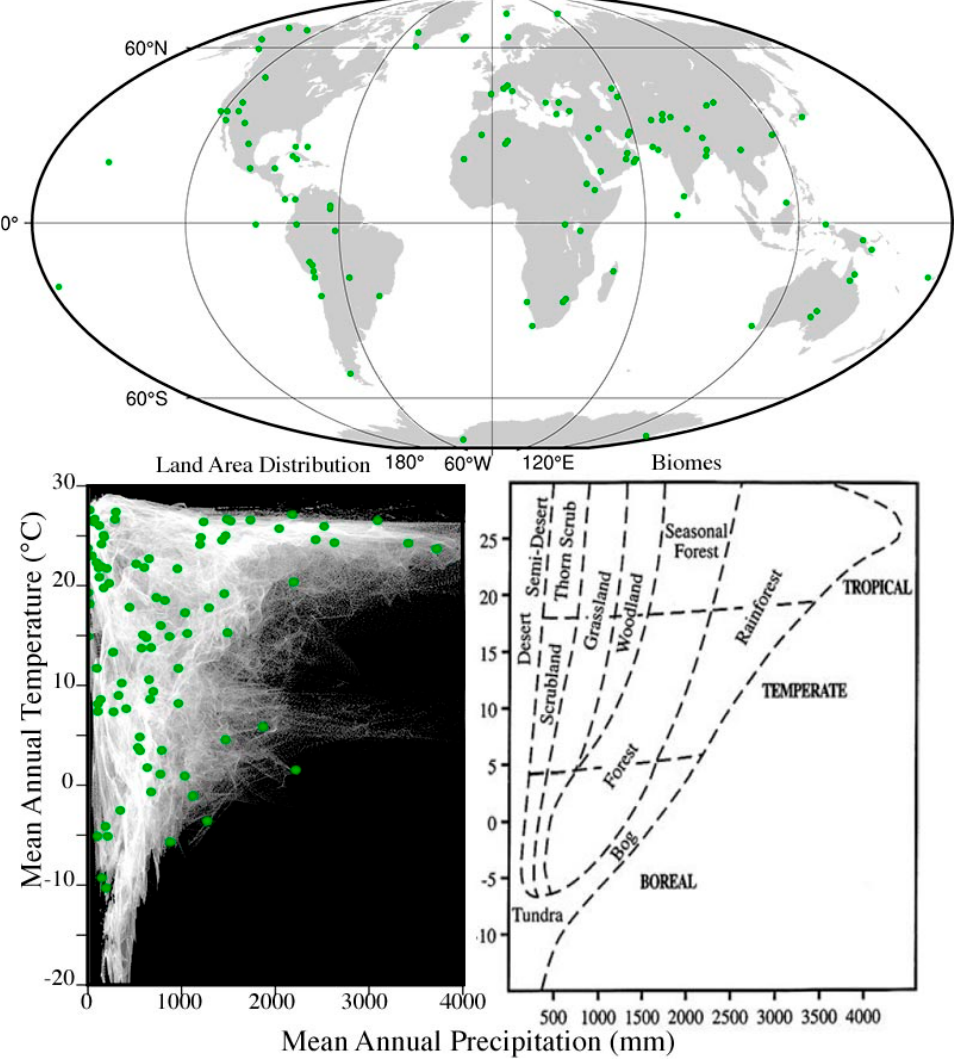
Figure 1. Geographic and climatic distributions of 110 Sentinel 2 tiles from spectral diversity hotspots. Geographic distribution of sample sites is guided by climatic and geologic diversity as well as overall species biodiversity. Individual tile selection criteria favor spectral diversity arising from land cover diversity within and across biomes. Tile geographic coverage corresponds well to global land area distribution within the climatic parameter space (lower left) based on 1° monthly from [14]. All biomes are well represented. Biome classification (lower right) adapted from